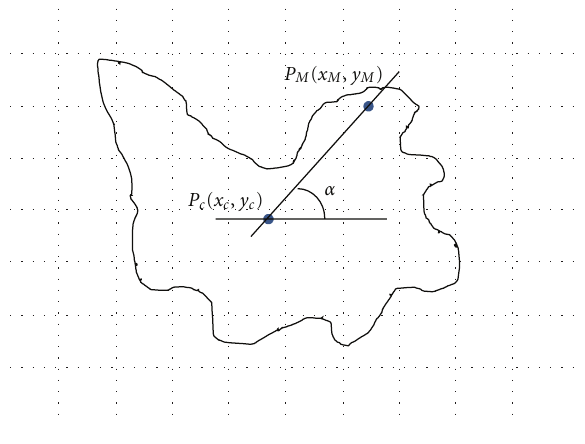
Figure 4: Anisotropic cell